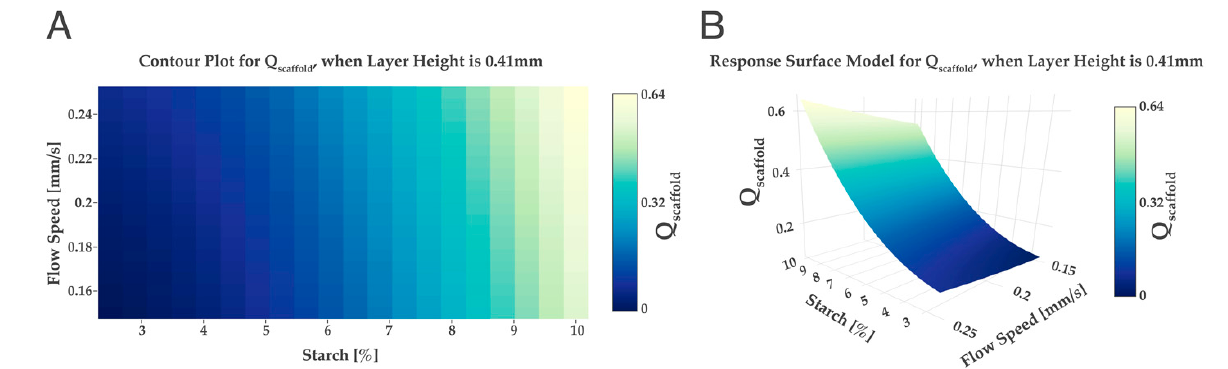
Figure 4. Qscaffold obtained for different wt% values of starch and flow speed when the layer height is kept at a constant value of 0.41 mm. Contour plot ( A ) and response surface model ( B ).